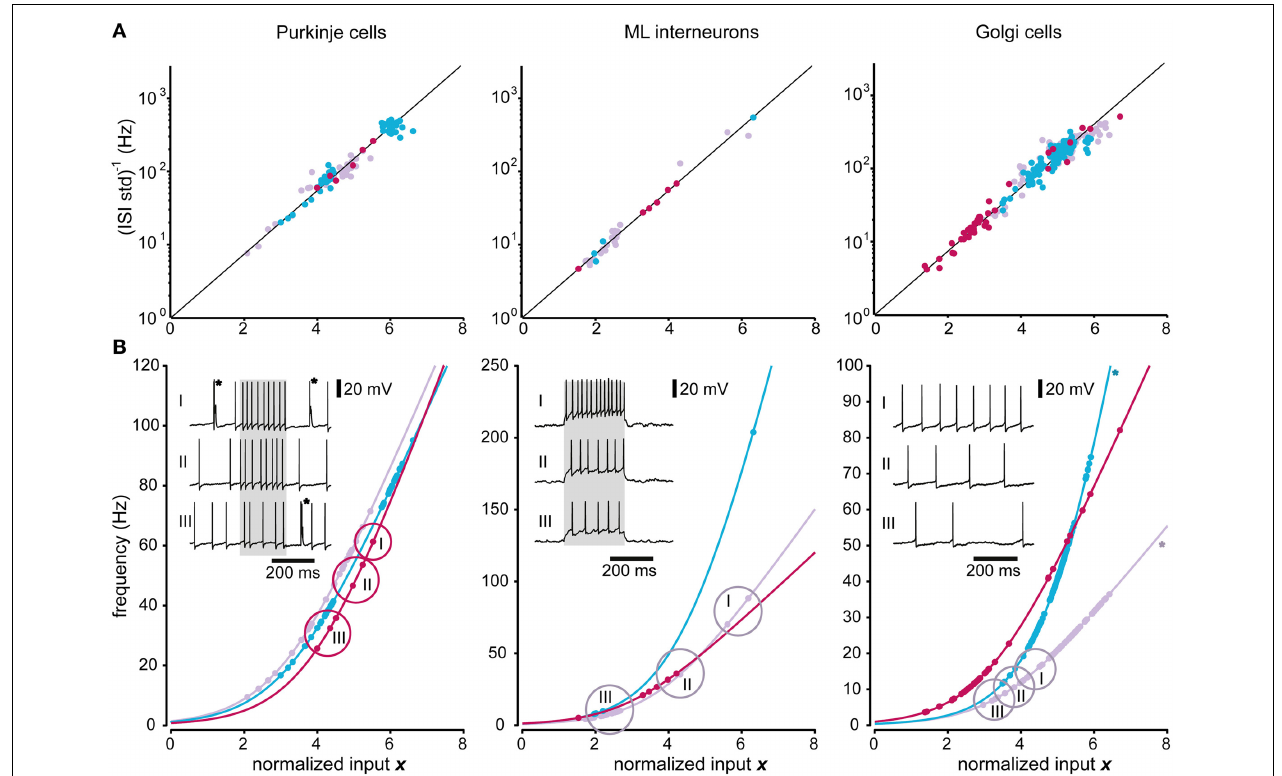
FIGURE 6 | Predictions of firing frequencies for neurons of the cerebellar cortex. Similar display as in Figure 5 but for the three different neuron types recorded in the cerebellar cortex. (A) Relationship between the normalized input and the inverse of the standard deviation. (B) Relationship between the normalized input and the mean firing frequency. The two Golgi cells that had correlated residuals (DW-test, p < 0 . 05) are marked by asterisks. For the